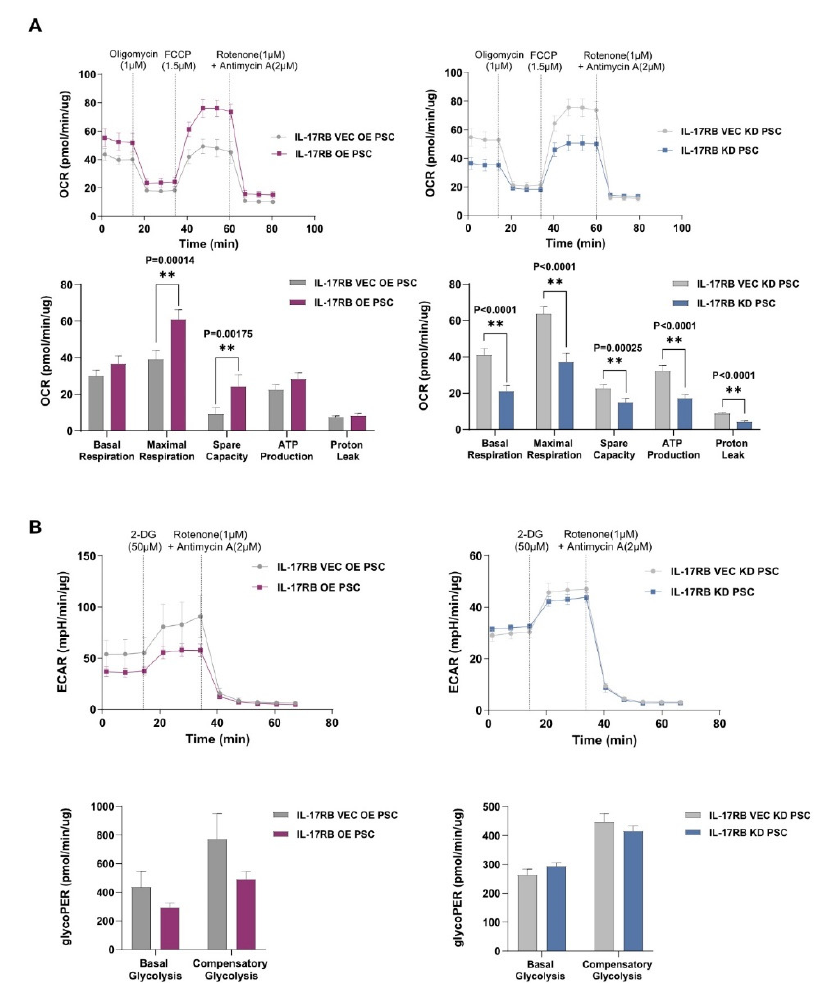
Figure 3. IL-17RB overexpression induces mitochondrial OXPHOS in PSCs ( A ) IL-17RB overex- pression increases and IL-17RB knockdown decreases mitochondrial respiration in PSCs. Oxygen consumption rate (OCR) was measured with the Seahorse mitostress test. Seahorse profiles (upper panel) and statistical analysis (unpaired t -test, lower panel). Data represent the mean ( ± SD) of three independent experiments conducted in quintuplicate; ( B ) IL-17RB overexpression decreases glycoly- sis in PSCs while IL-17RB knockdown induces no changes. Statistical significance was not reached in either group. The glycolytic proton efflux rate (glycoPER) correlates with lactate accumulation over time, showing glycolysis: seahorse profiles (upper panel) and statistical analysis (unpaired t -test, lower panel). Data represent the mean ( ± SD) of three independent experiments conducted in quintuplicate. ** p < 0.01.